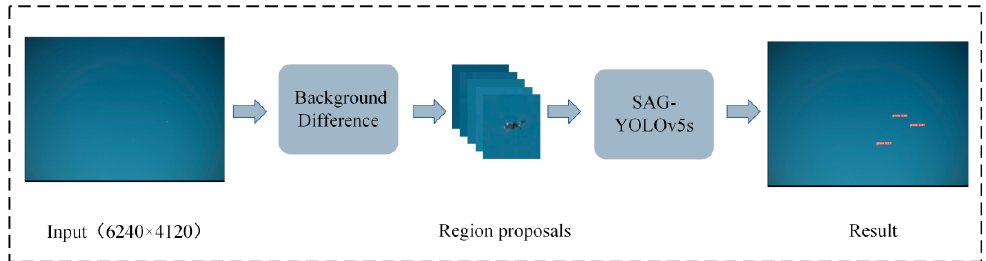
Figure 1. The steps in this paper to detect high-resolution drones with fixed cameras.